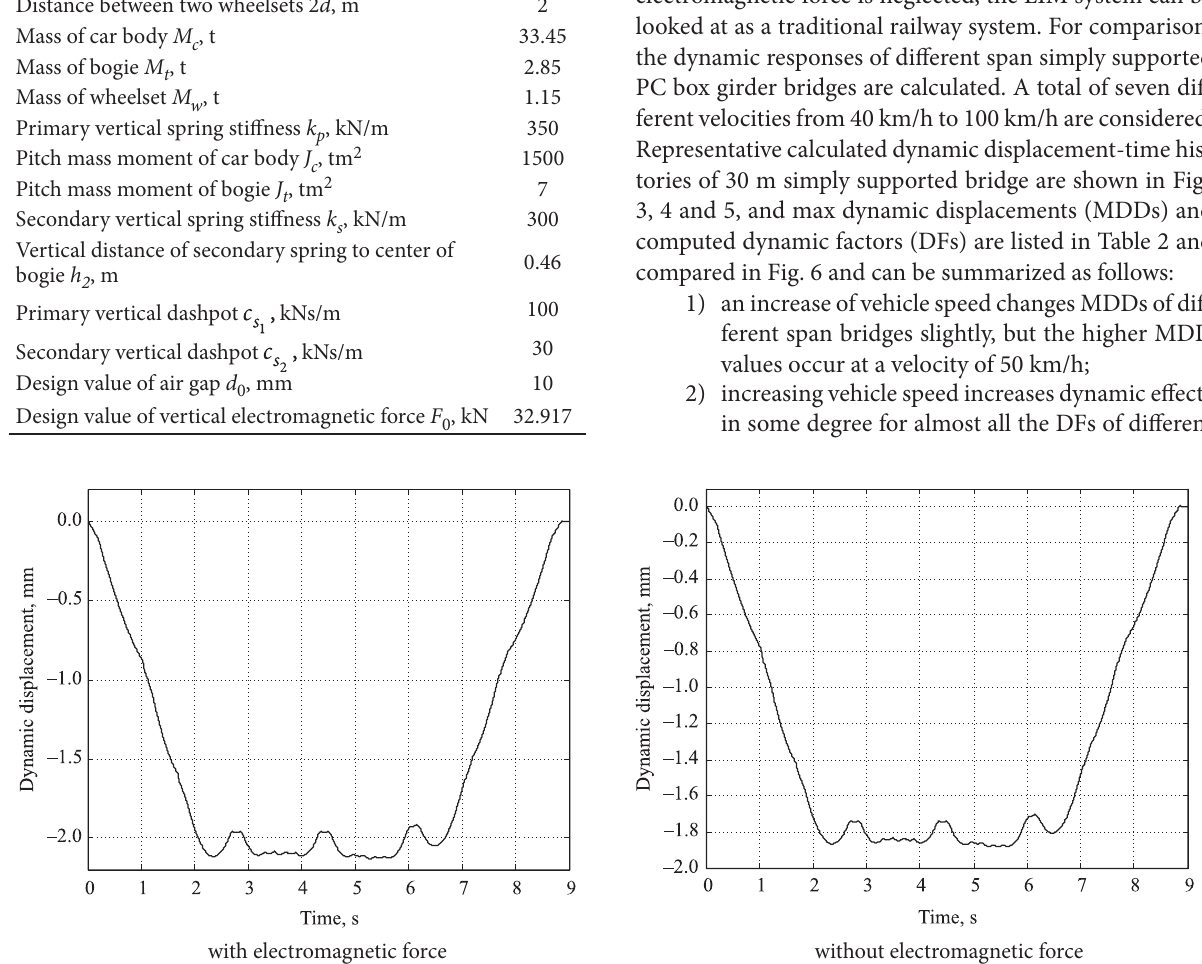
Fig. 3. Calculated dynamic displacement time-histories of 30 m simply supported bridge for velocity 40 km/h